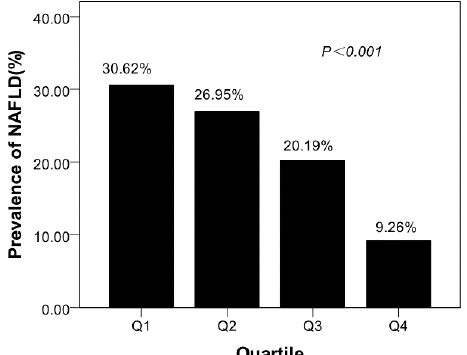
Figure 1. Prevalence of non-alcoholic fatty liver disease (NAFLD) in different quartiles of osteocalcin. The prevalence of NAFLD from the lowest to highest osteocalcin quartile were 30.62%, 26.95%, 20.19%, 9.26%, respectively ( p <